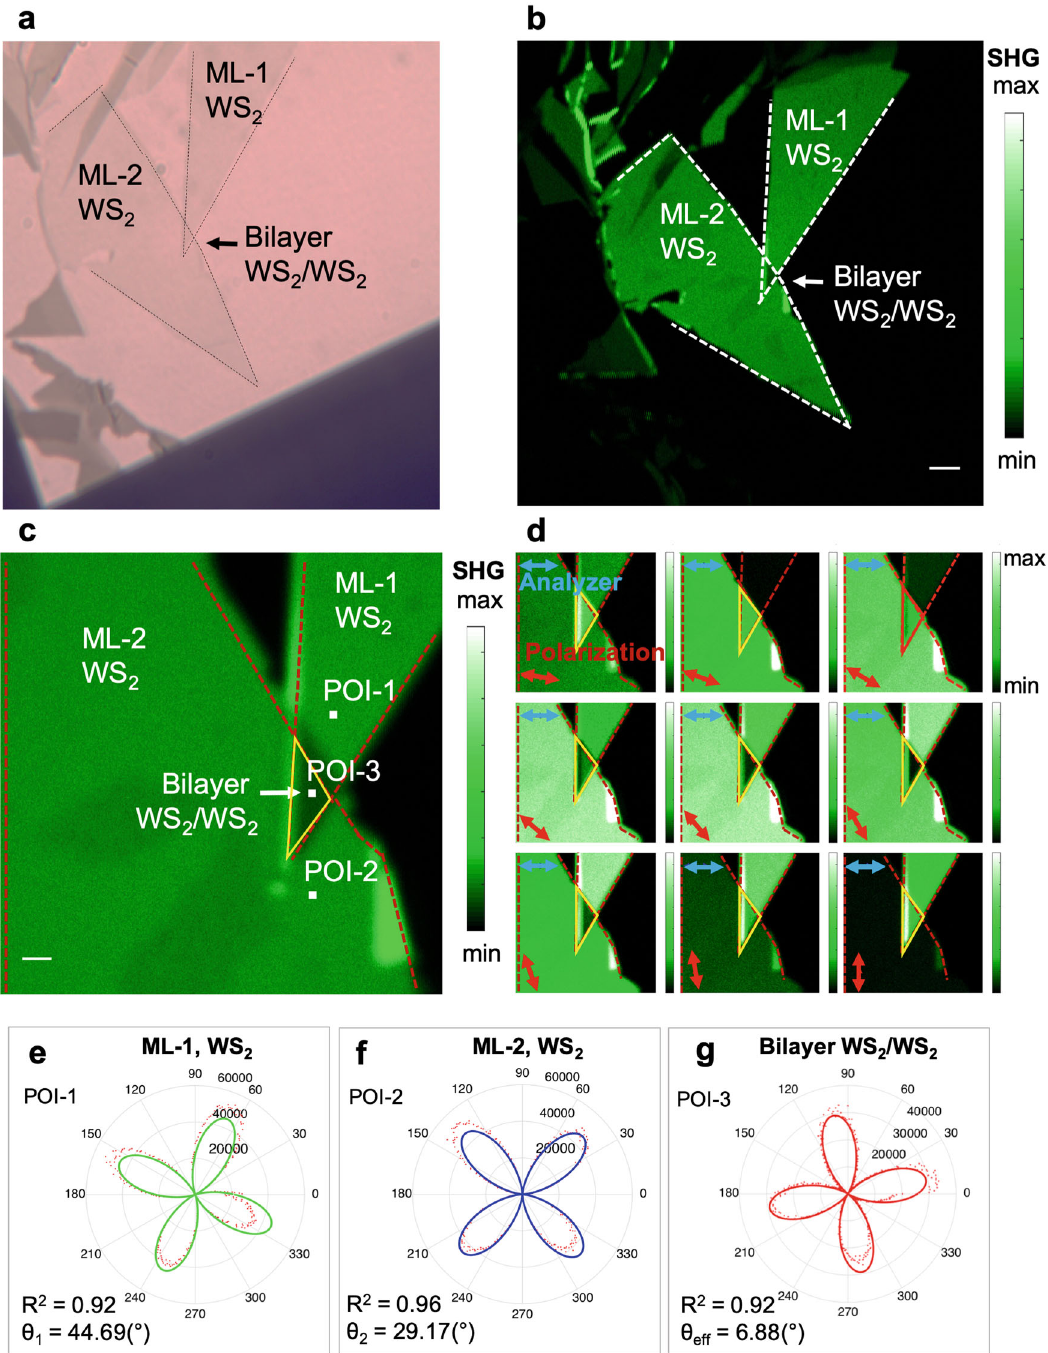
Fig. 3 P-SHG microscopy of WS 2 /WS 2 bilayer on a TEM grid. a Wide fi eld microscopy using the CCD camera of the microscope. We note two individual MLs of WS 2 (ML-1 and ML-2), overlapping in a bilayer WS 2 /WS 2 region. b SHG imaging of the same region seen in a., without the use of the analyzer in the detection path (see Fig. 1b, d). This ensures that all of the produced SHG signals will be acquired in the same image. Scale bar indicates 5 μ m. c A zoom of the SHG image seen in ( b ). Three pixels-of-interest (POI) are chosen. One from the WS 2 ML-1, one from the WS 2 ML-2 and one from the WS 2 /WS 2 bilayer region. Scale bar shows 1 μ m. d P-SHG images of the region seen in c . for fi xed analyzer ( ζ = 0 (°)), indicated by a blue double arrow and rotating linear excitation polarization ( φ ∈ [10(°) – 90(°)], with step 10(°)), indicated by a red double arrow. e , f Experimentally retrieved P-SHG polar diagrams for the POIs 1,2, respectively. The polarization rotates with φ ∈ [0(°) – 360(°)], and step 1(°) and the analyzer is fi xed at ζ = 0(°). The solid lines (green for ML-1 and blue for ML-2) are the fi ttings of Eq. (1) to the P-SHG data. This resulted to armchair directions θ 1 = 44.69(°), R 2 = 0.92 and θ 2 = 29.17(°), R 2 = 0.96 for ML-1 and ML-2, respectively, where R 2 denotes the quality of the fi tting. g Experimentally retrieved P-SHG data for POI 3 in the WS 2 /WS 2 bilayer region using the same rotating polarization φ ∈ [0 (°) – 360(°)], with step 1(°) and fi xed analyzer at ζ = 0(°) as in ( e , f ). The solid red line is the fi tting of Eq. (3) to the P-SHG data and θ eff = 6.88(°), R 2 = 0.92 is the result of the fi